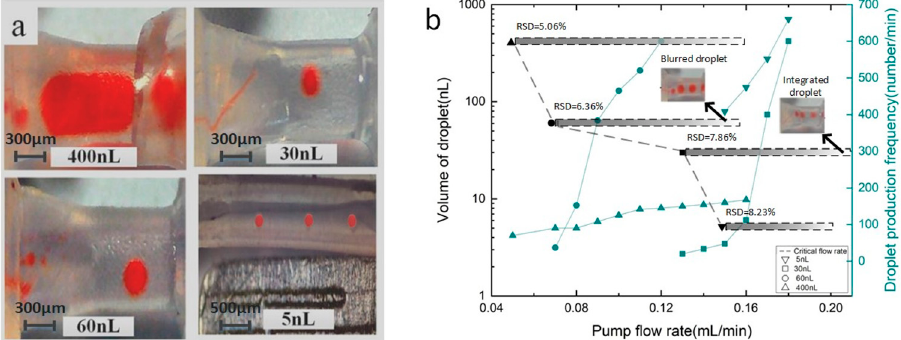
Figure 3. Study on droplet controllability. ( a ) Shows the droplet volumes were about 400 nL, 60 nL, 30 nL, and 5 nL, respectively, and ( b ) summarizes the critical flow rate of a droplet generator for four kinds of droplets.